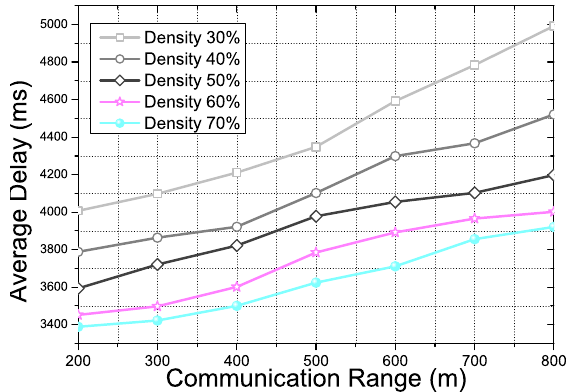
Figure 13. Average delay for communication range and density rate. Using the same experimental conditions in Figures 13 and 14, they show the average delay for the communication range and the average density rate. The average delay gets affected by communication distance and PDR due to transmission failure. TSF and BAHG, with a single packet forwarding mechanism based on trajectory information, show a higher average delay than other comparison protocols, including the proposed